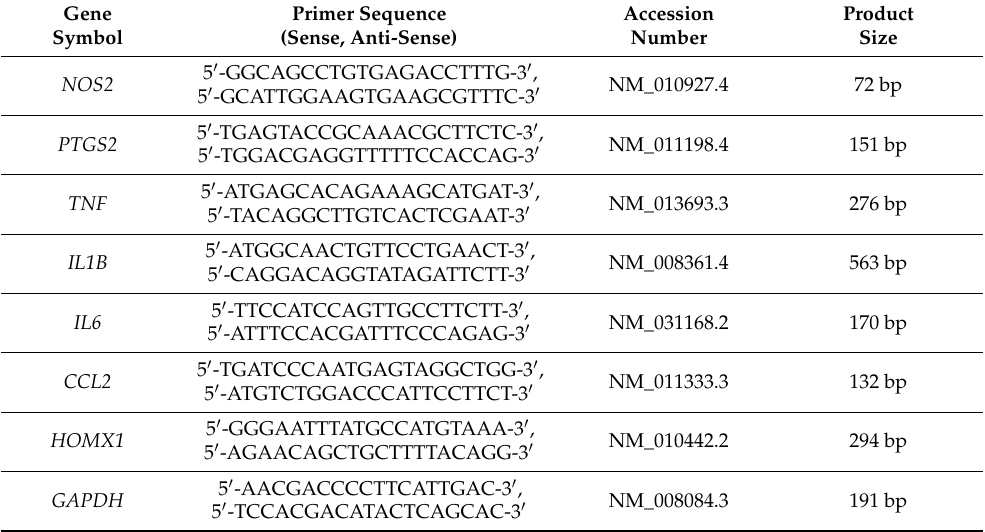
Table 1. Oligonucleotide sequences used in RT-qPCR